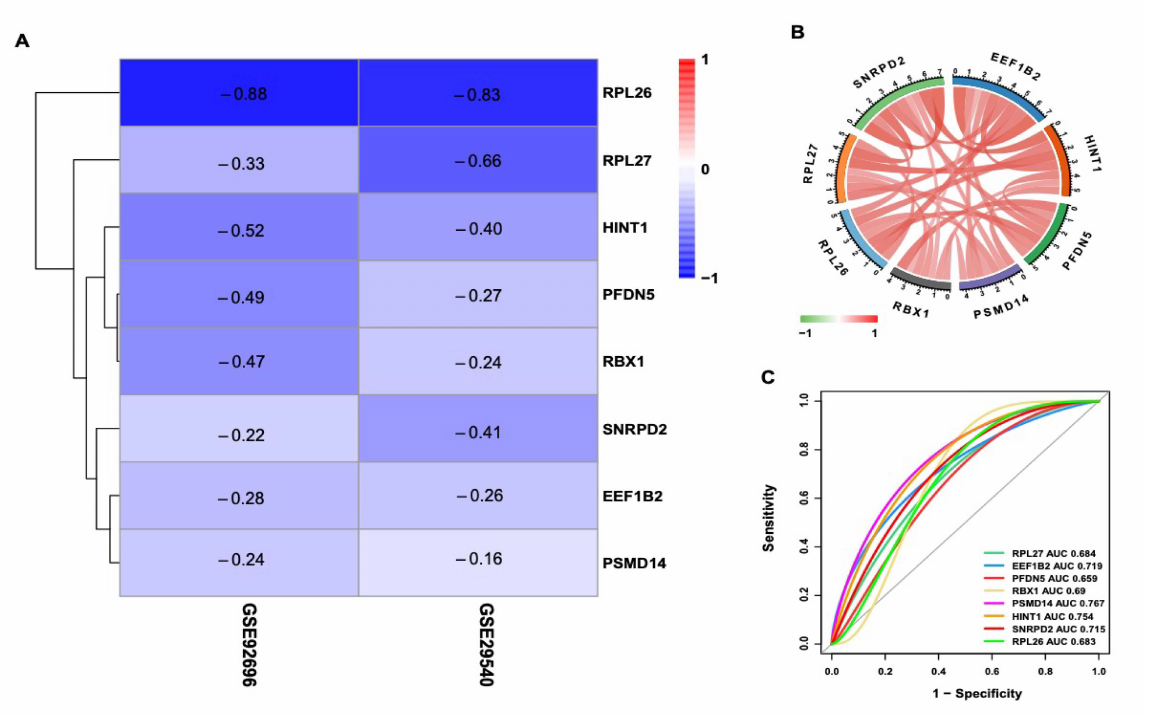
Figure 4. Validation of the hub genes. ( A ) Heatmap displays the log2(FC) values of the hub genes in GSE92696 and GSE29540. ( B ) Correlation of 8 hub genes in GSE92696. The red line represents a positive correlation, the green represents a negative correlation, and the deeper the color, the stronger the correlation. ( C ) The ROC curves of the hub genes in